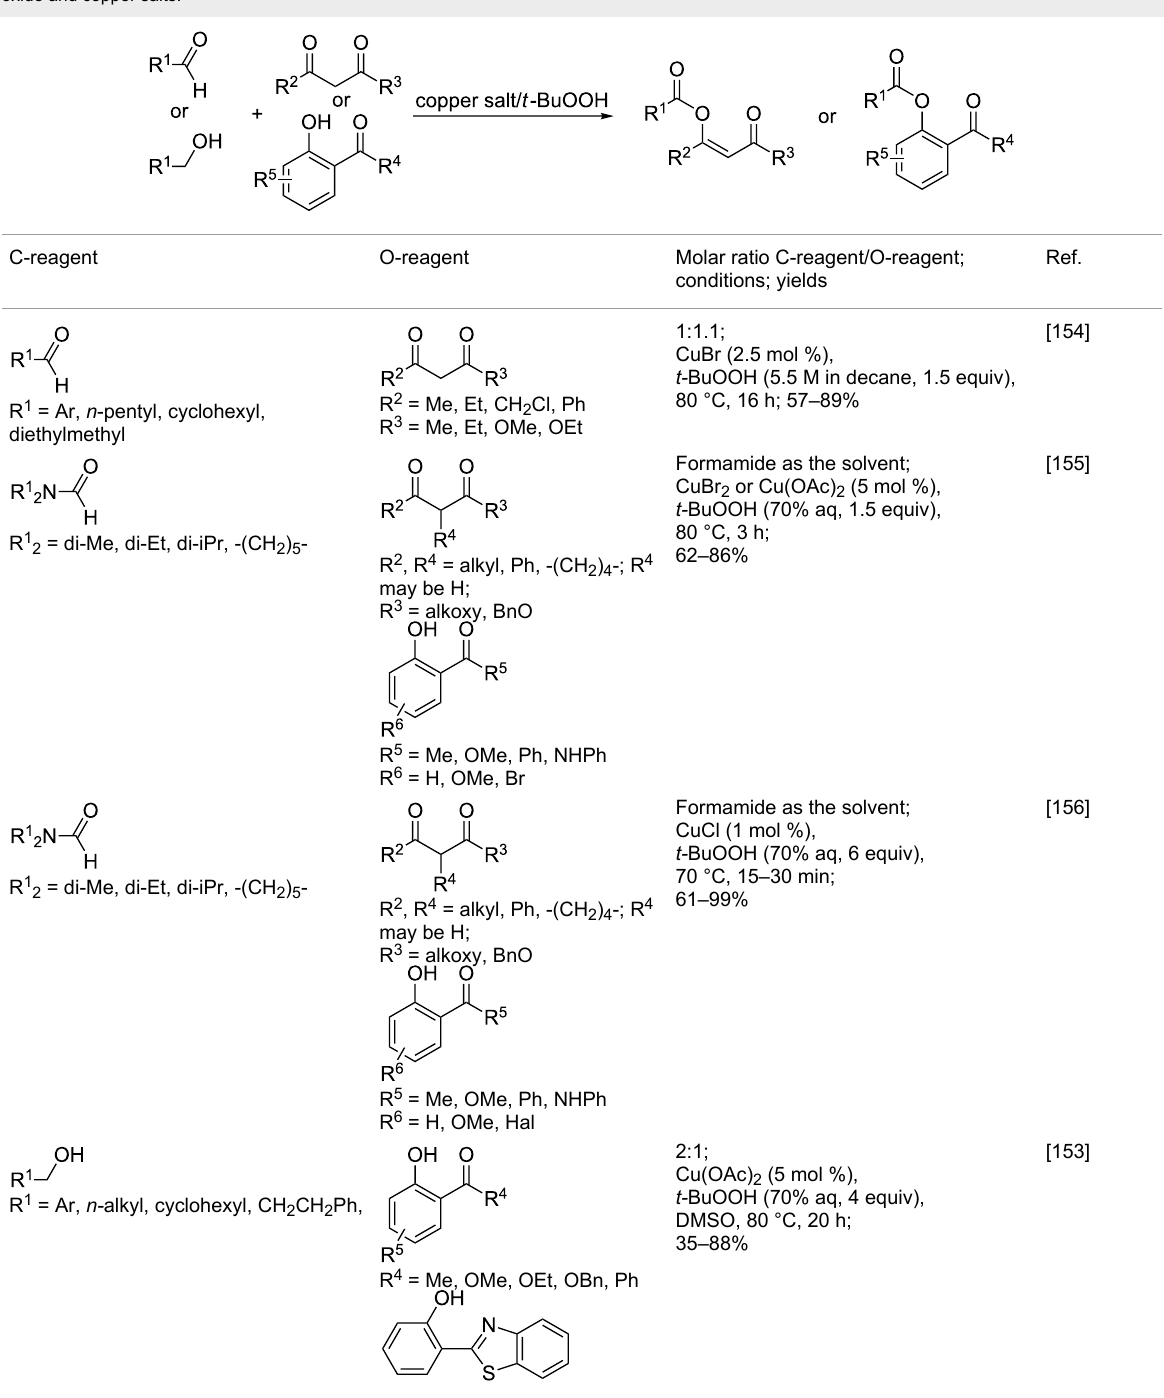
Table 5: Oxidative coupling of alcohols, aldehydes, or formamides with 1,3-dicarbonyl compounds or phenols in the presence of tert -butyl hydroper- oxide and copper salts.